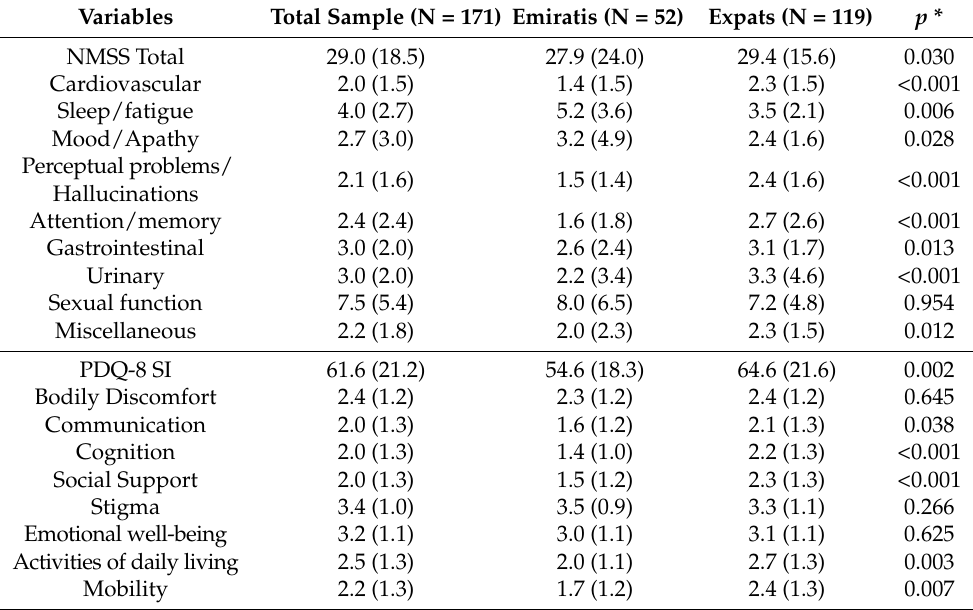
Table 2. Scales scores and differences by origin of the patients.